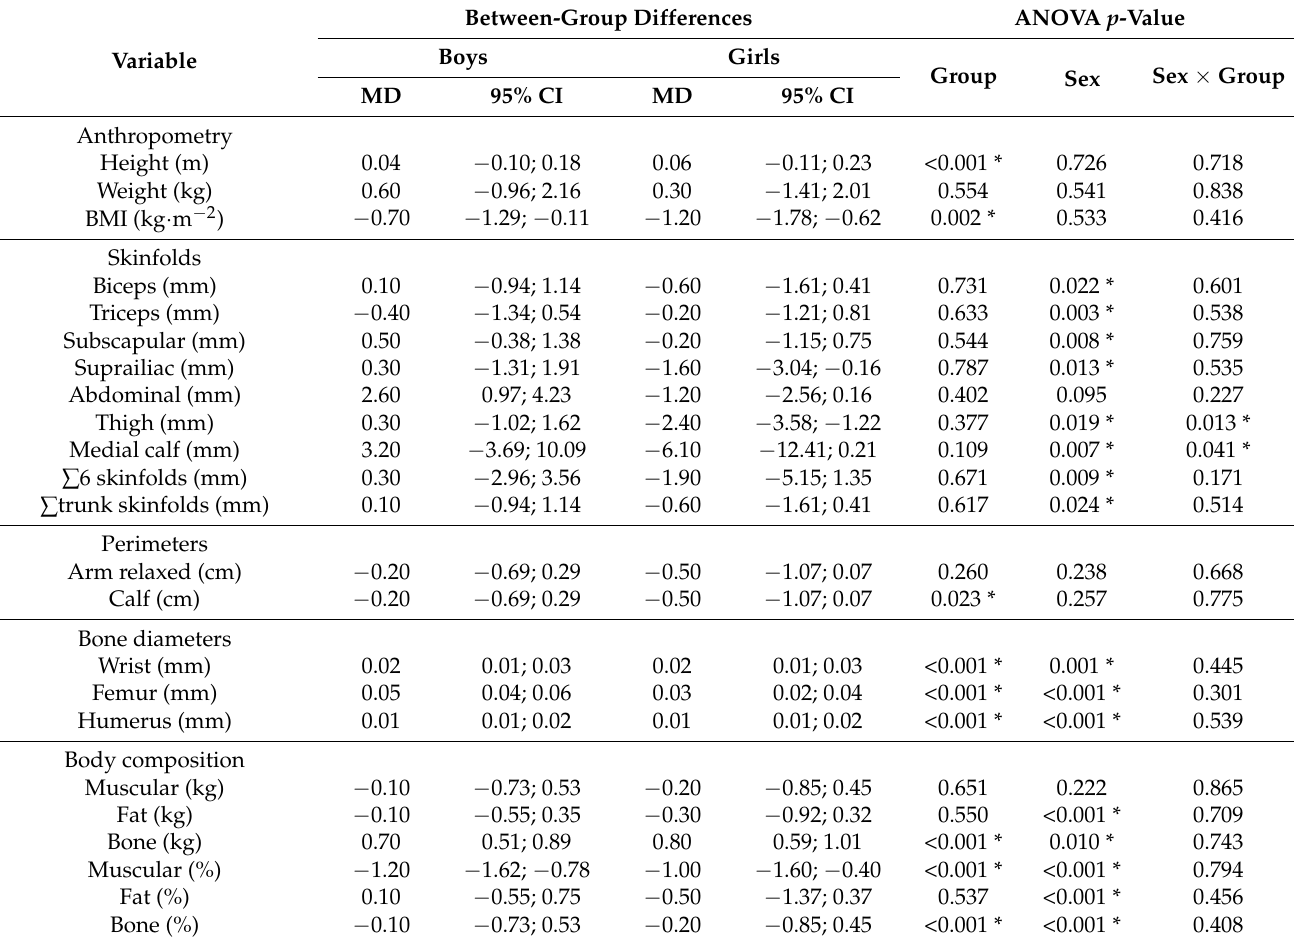
Table 2. Means difference (MD) between table tennis players and physically active